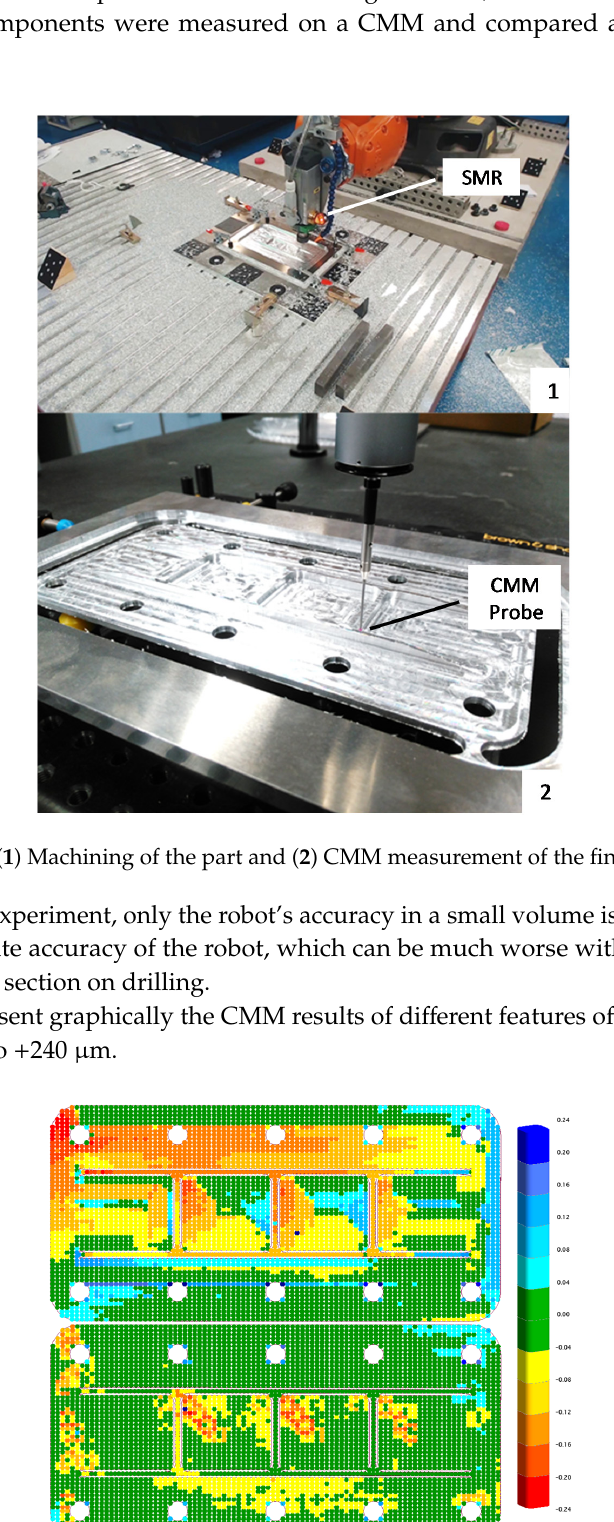
Figure 28. Comparison of measured periphery of the part vs. nominal CAD. (top) without feedback; (bottom) with feedback. Errors are indicated in mm. The stiffener profiles are shown in Figure 29. While real-time compensation significantly improved the accuracy of the feature, the inside corners of the pockets are not very well machined. The conventional pocketing toolpath used likely led to sudden increase in cutter engagement at the corners. The robot may not be able to compensate for the sudden increase in force required in time, even with laser tracker compensation. Increased vibration was also observed during machining of the stiffeners, likely a result of the thin features and the part having poor mechanical support towards the middle.